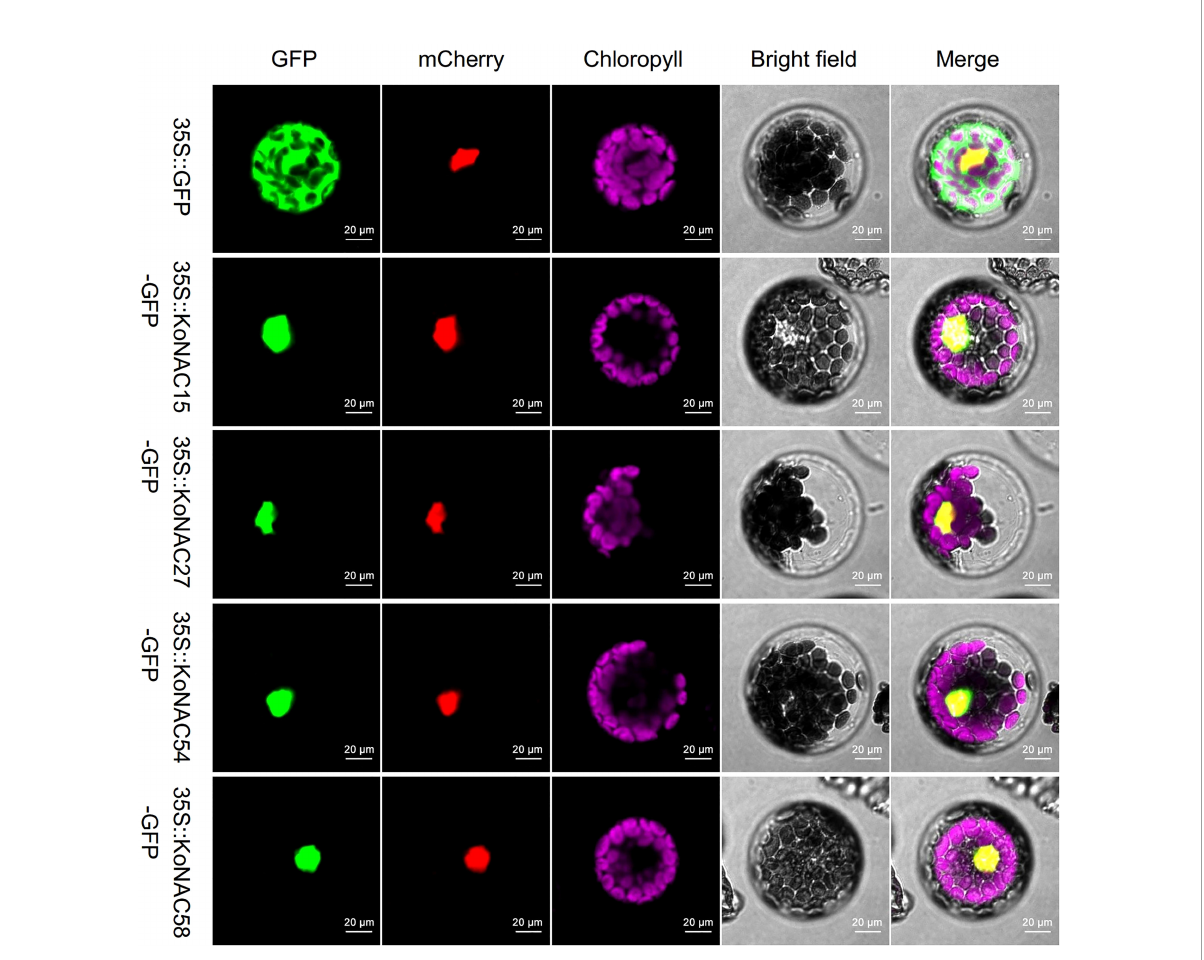
FIGURE 7 KoNAC-GFP fusion vectors were used to determine the subcellular localization of several KoNACs in Arabidopsis thaliana protoplast cells. The 35S::EGFP (green) construct used as a negative control was extensively observed in both the nucleus and the cytoplasm of A. thaliana protoplasts. A nuclear-localized 35S::mCherry protein (red) was applied to mark the nucleus. Chlorophyll auto fl uorescence (purple) demonstrates the location of chloroplasts. Scale bar = 0.02